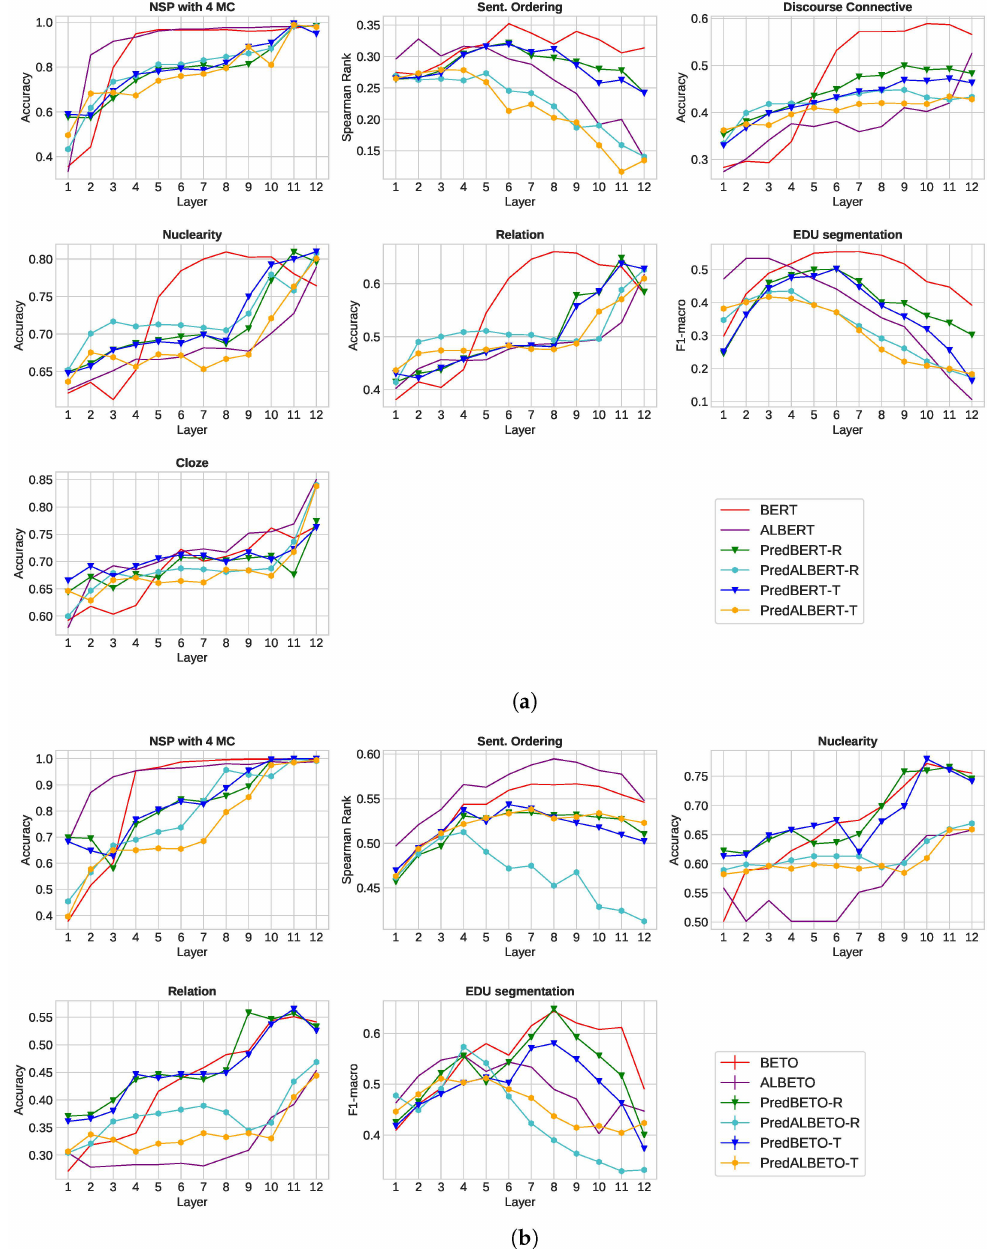
Figure 3. Document-level discourse probing task performance for each of the five tasks. We perform the evaluation three times with different initial seeds. ( a ) Results for models in English; ( b ) Results for models in